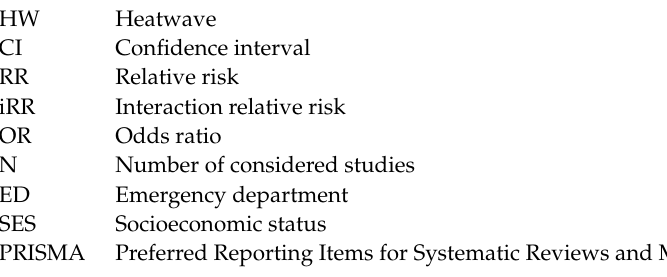
strategy. Table S2: Included studies, per category. Tables S3–S7: Studies’ classification, per